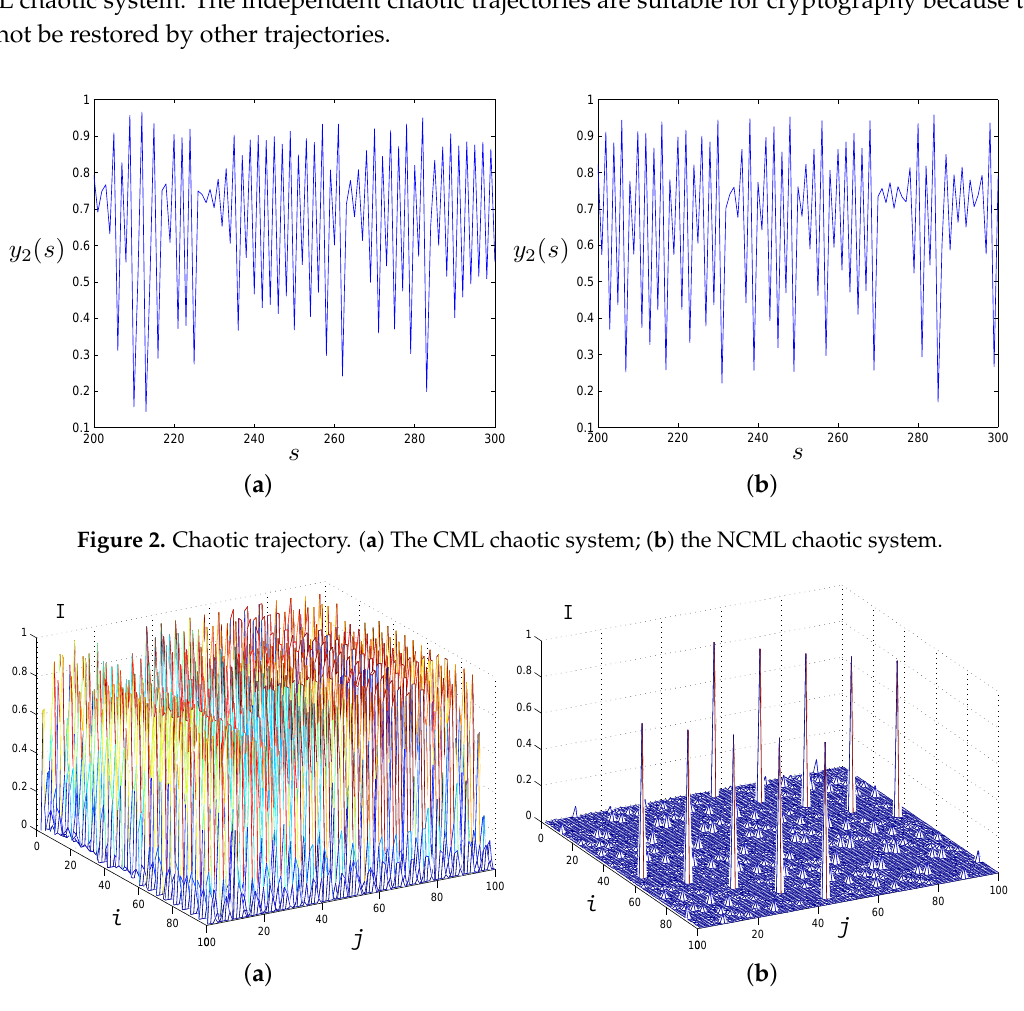
Figure 3. Mutual information. ( a ) The CML chaotic system; ( b ) the NCML chaotic